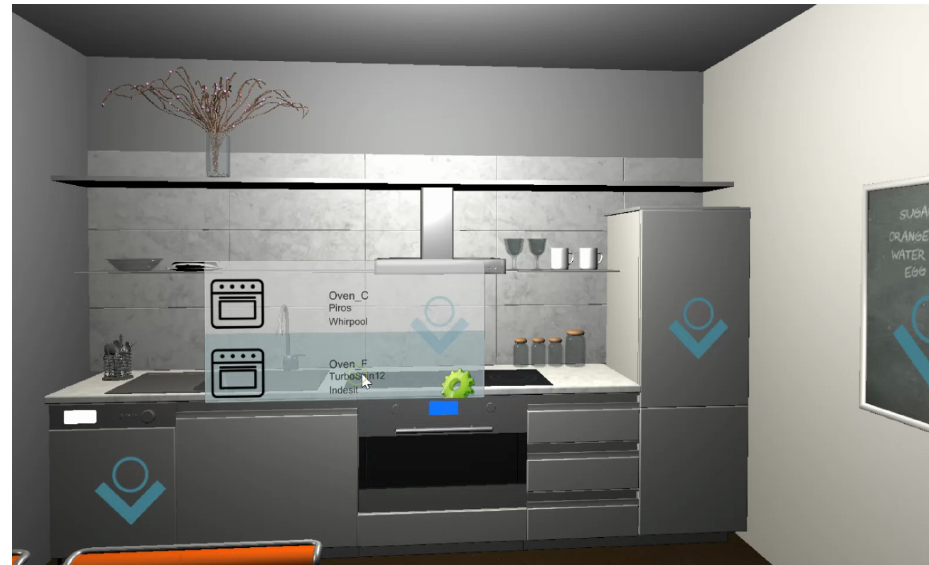
Figure 7. A snapshot of RecAAL: The designer chooses the appliance from those suggested by the Decision Support System (DSS), as suitable for the resident.